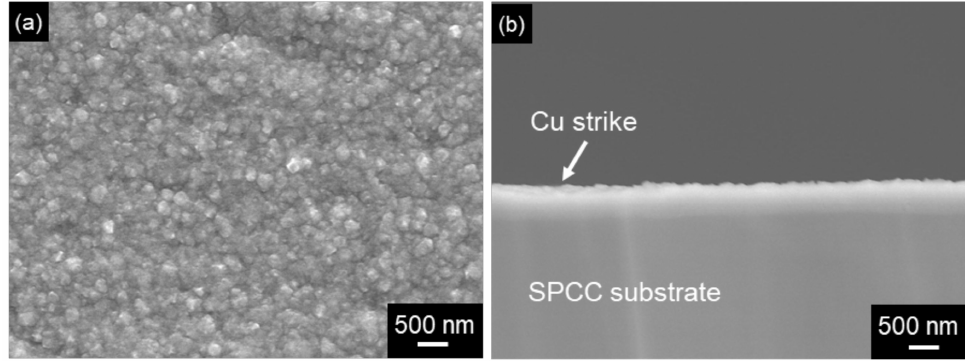
Figure 3. SEM images of copper strike: ( a ) Surface; ( b ) Cross